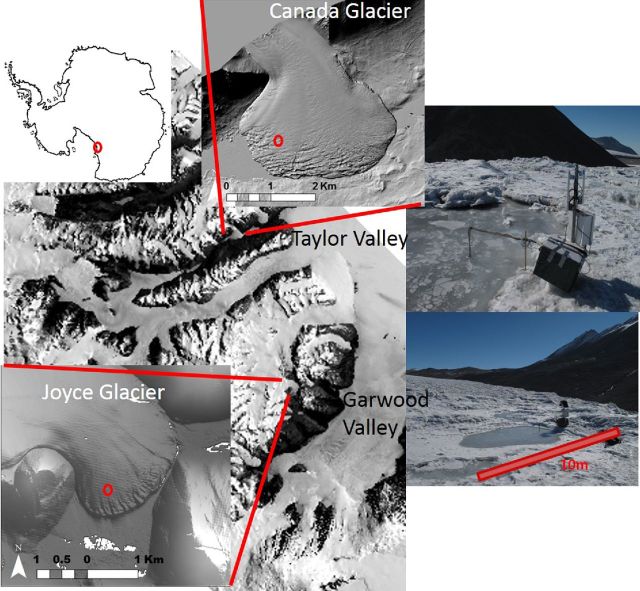
Location of Joyce Glacier, Garwood Valley, McMurdo Dry Valleys, Antarctica, where temperature, DO and EC probes were installed in a cryolake in January 2010. The map also shows where samples were collected for laboratory incubations from a cryoconite hole on Canada Glacier, Taylor Valley, Antarctica.